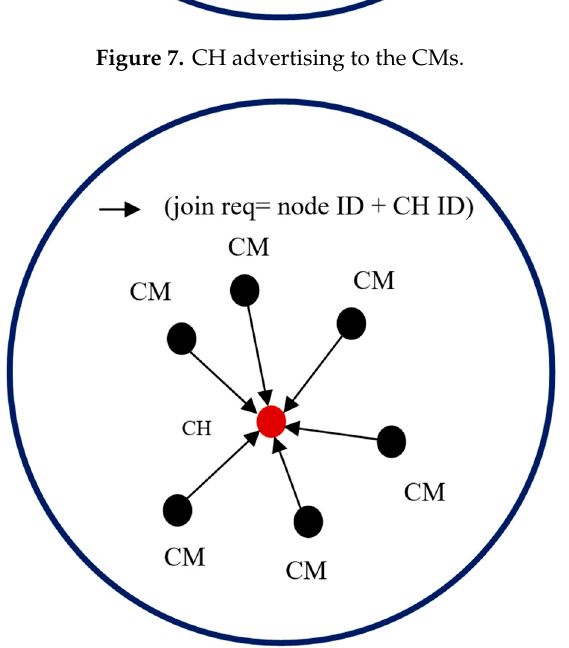
Figure 8. CMs sending join request to the CH.